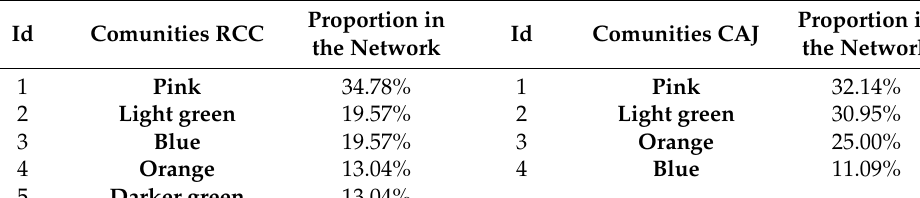
Table 3. Communities of pages identified on the Facebook pages of RCC and CAJ.